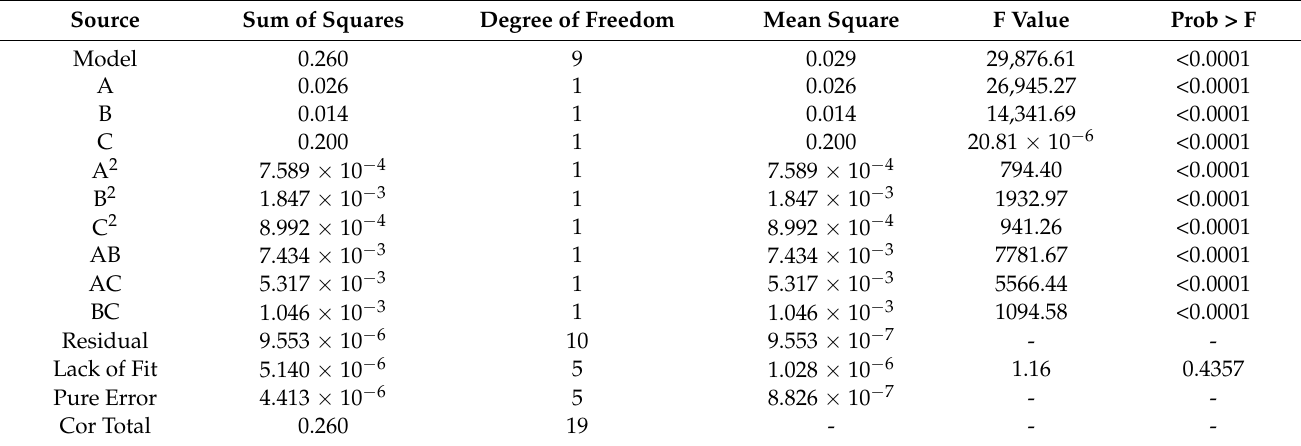
Table 3. ANOVA of the CO 2